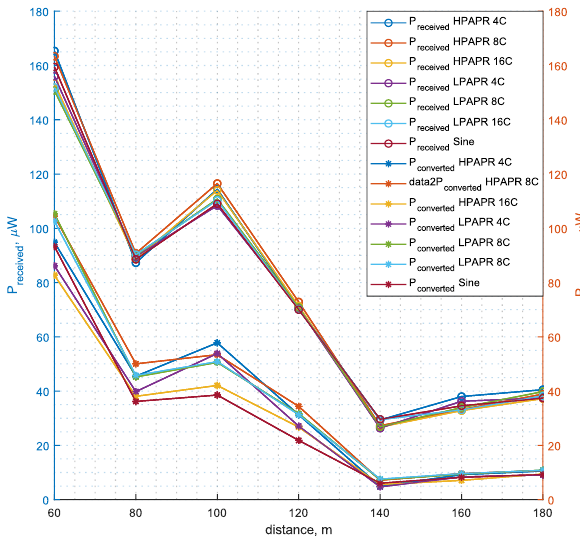
Fig. 12. Received average power level on antenna output and DC-DC converters average output power